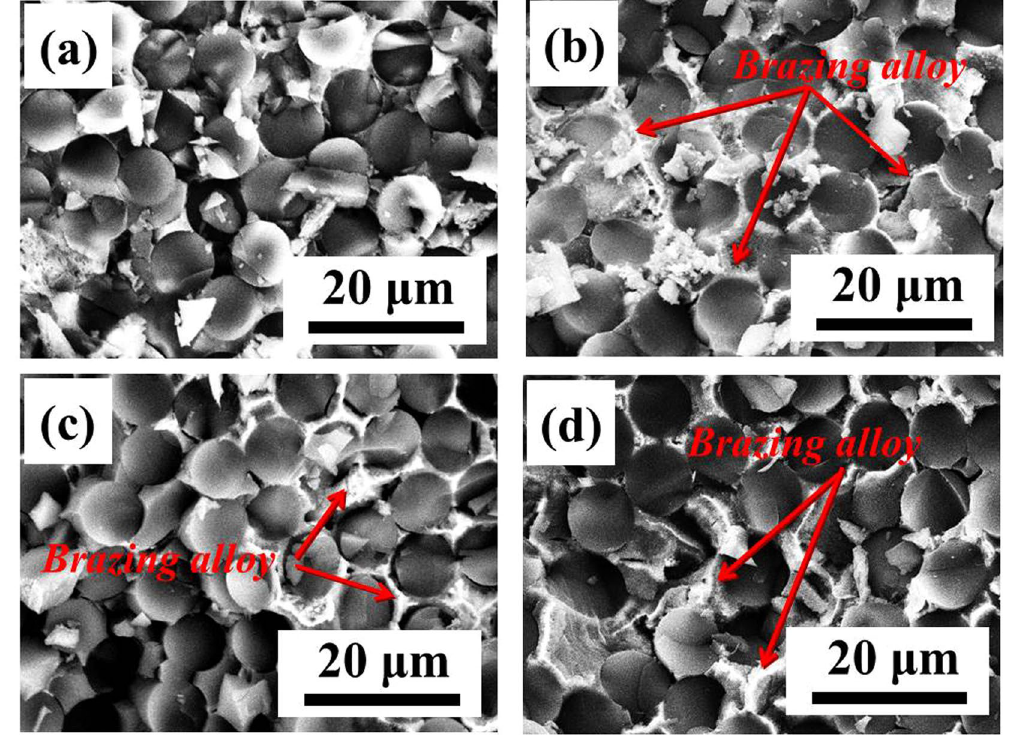
Figure 13. SEM images of the fracture surface in ( a ) 0 μ m@E-SiO 2f /SiO 2 -Nb, ( b ) 50 μ m@E-SiO 2f /SiO 2 -Nb, ( c ) 100 μ m@E-SiO